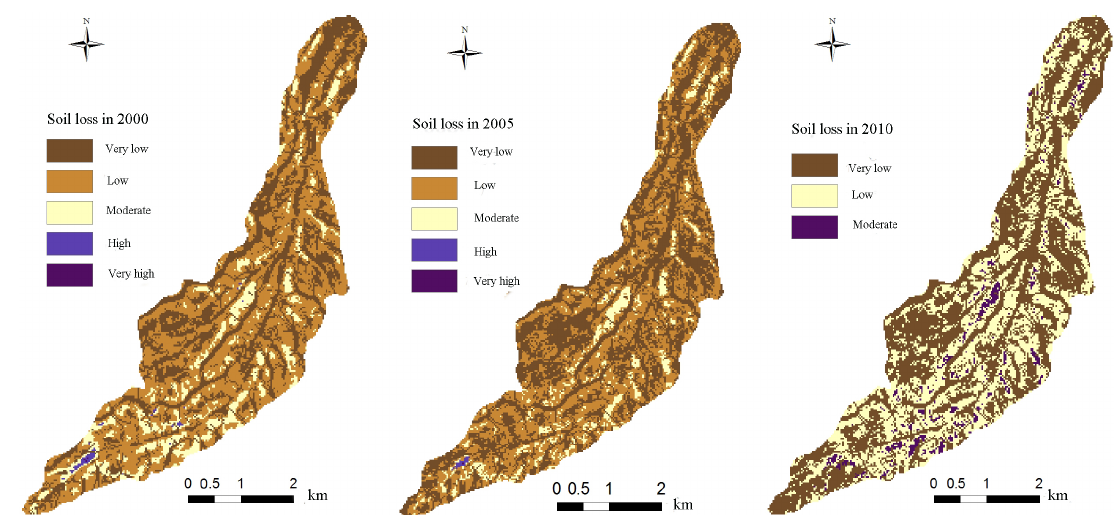
Figure 14. The spatial distribution of soil loss estimated using RUSLE for each of the study